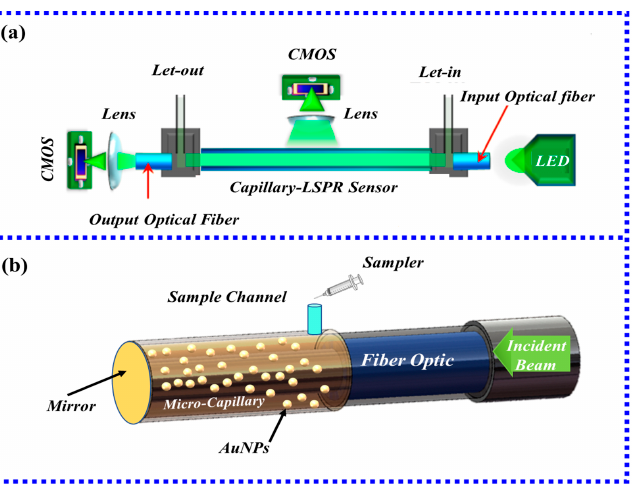
Figure 14. ( a ) Schematic diagram of the plasmonic sensing device based on capillary LSPR sensor [95]; ( b ) Schematic diagram of reflective structure based on HCF.